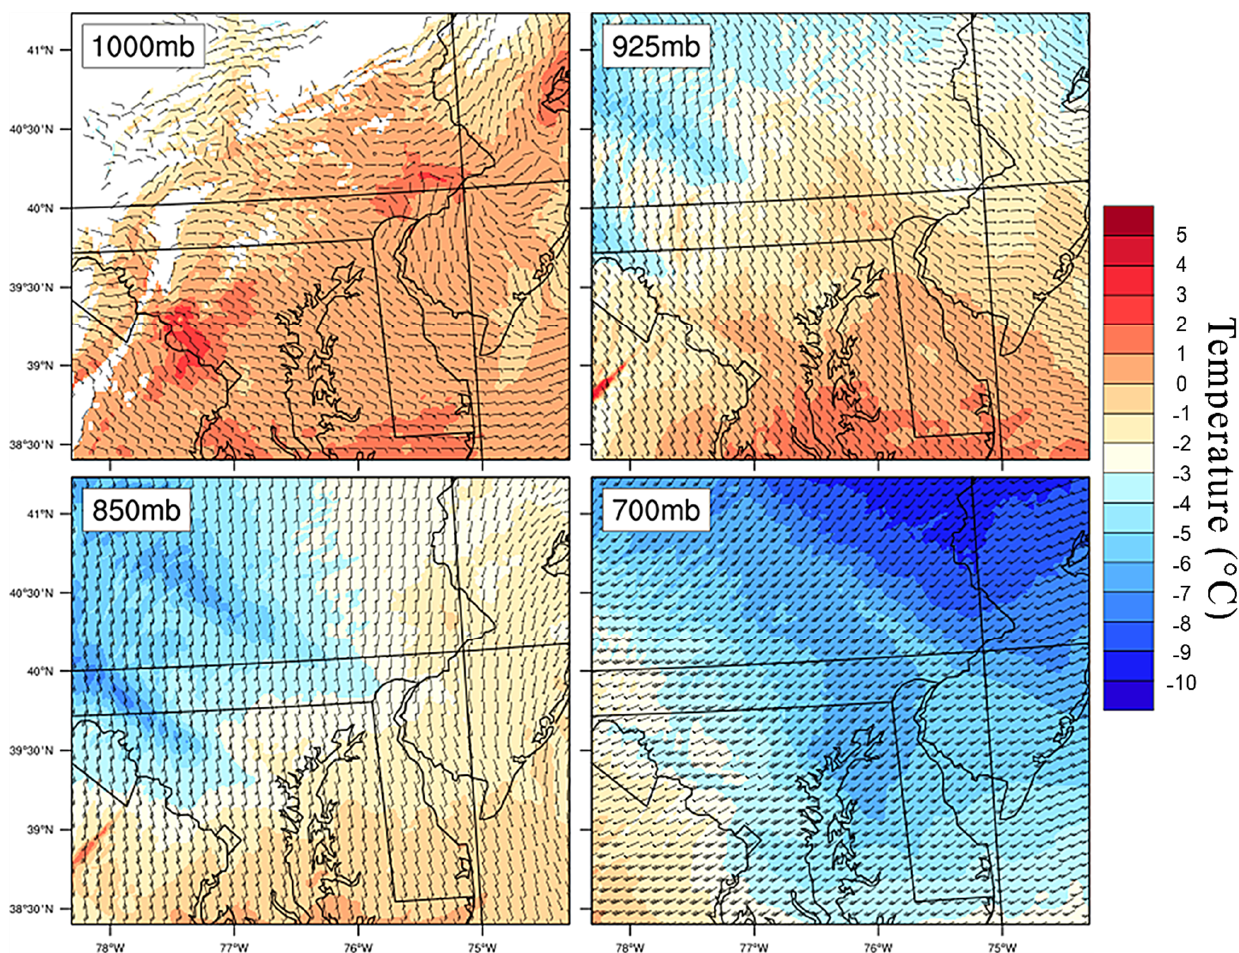
Figure 8. WRF-simulated air temperature (°C) and winds, u , (kt) in the control simulation at 1000, 925, 850, and 700 mb. Valid at 0000 UTC on 6 February 2004.